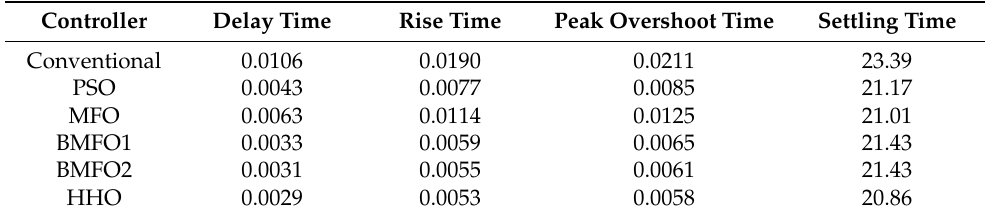
Table 11. Graph analysis of deviation in actual tie-line power flow with various controllers under bilateral contract.